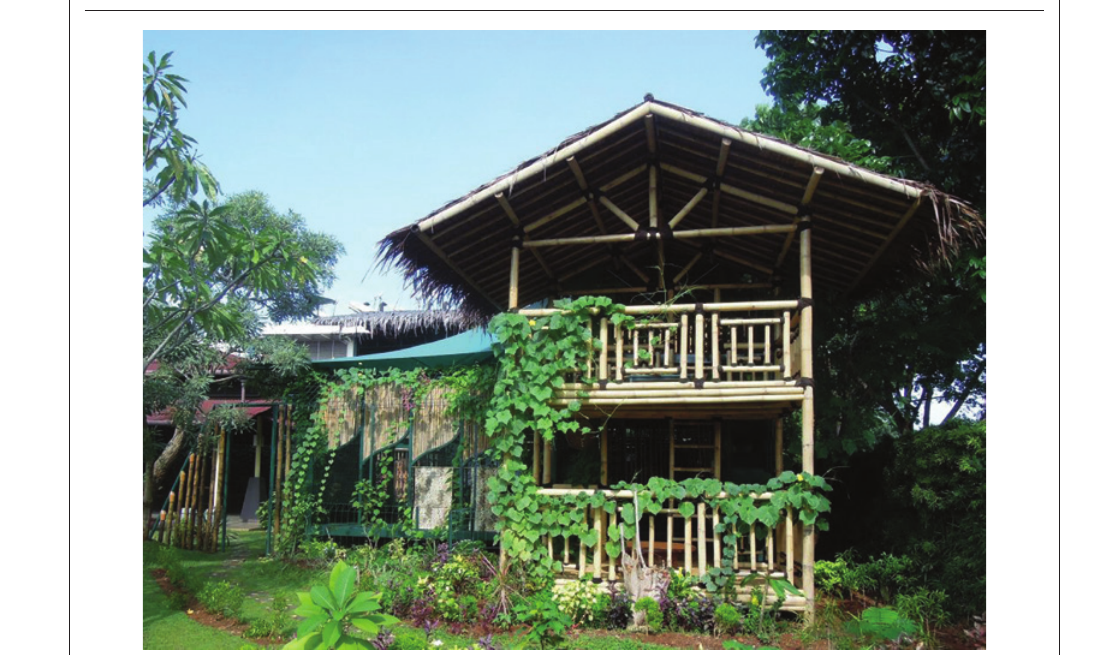
figure 4: Sekolah aman (Source: elisabeth barratt Hacking,